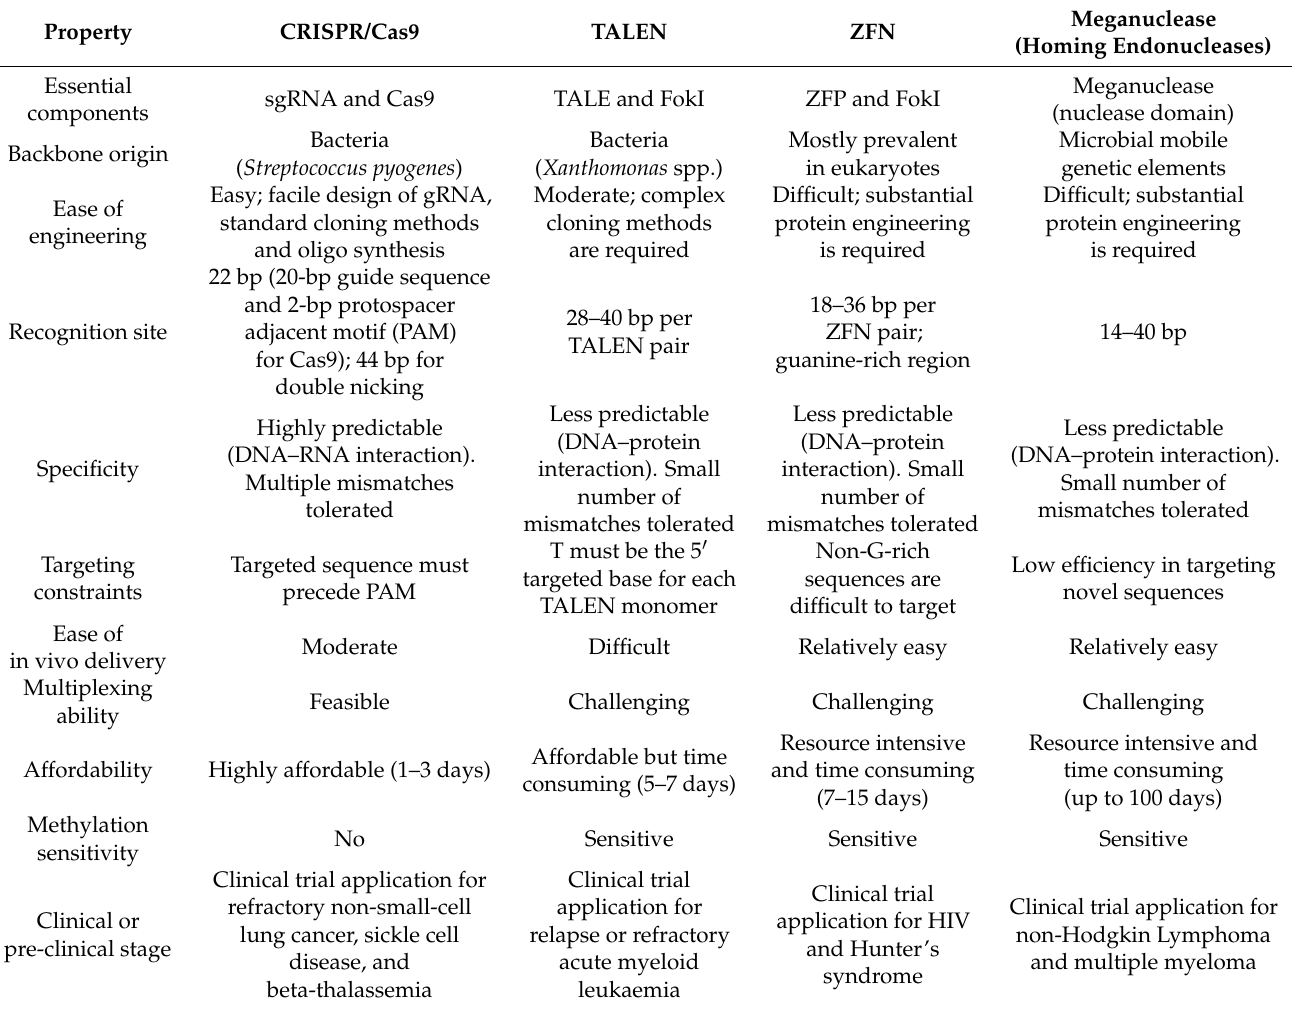
Table 2. Comparison of core genome-editing tools in the 21st